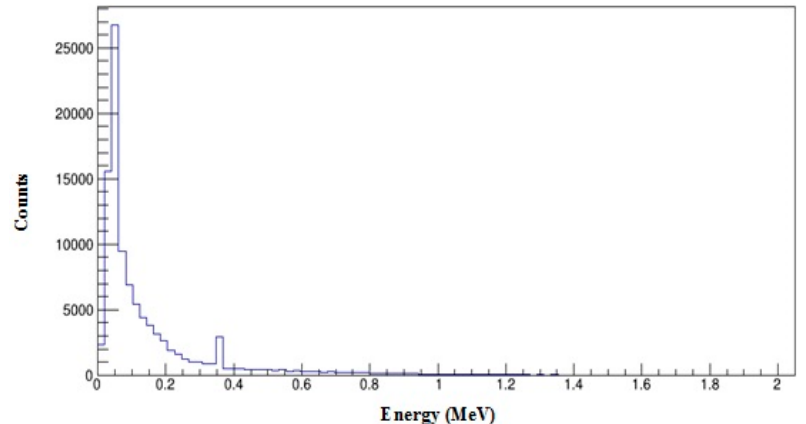
Figure 11. Gamma spectrum for 159 Gd detected from output GATE MC simulation root file, using ROOT software.